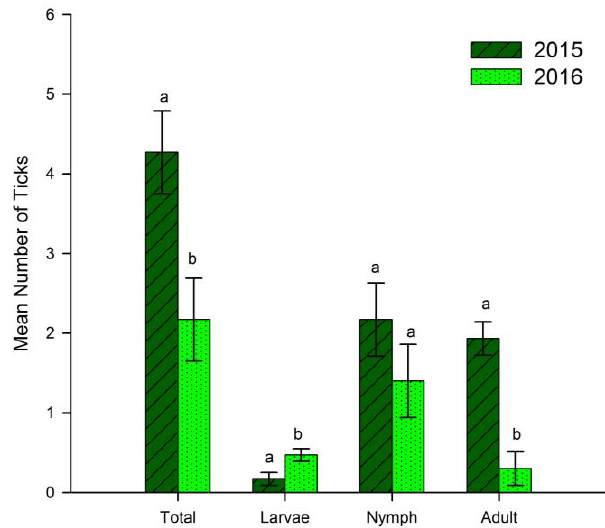
Figure 1. Mean counts of Amblyomma americanum (L.) by life stage, collected from transects in 2015 ( n = 30 transects) and 2016 ( n = 30 transects) at Alice L. Kibbe Field Station in Hancock County, west-central Illinois. Bars superscripted with different letters indicate significant differences ( p < 0.05) between years as indicated by one-way ANOVA. Larval ticks were considered present (1) or absent (0), means of presence and absence are depicted. Error bars represent one standard error.